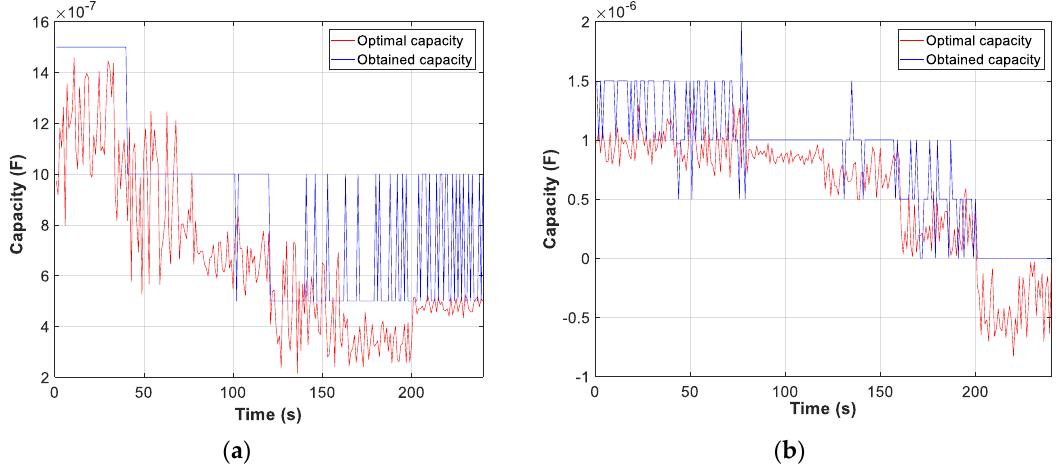
Figure 7. Comparison obtained vs optimal capacity: ( a ) Motor in W; ( b ) Motor in D.